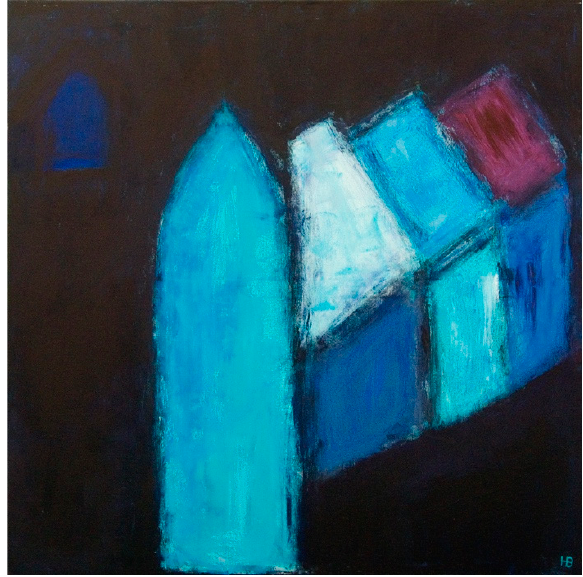
Figure 7. Hannah Bischof, “ Kirchenschiff mit blauem Haus ”, acrylic on canvas, Berlin 2013, © Ben Figure Bischof.